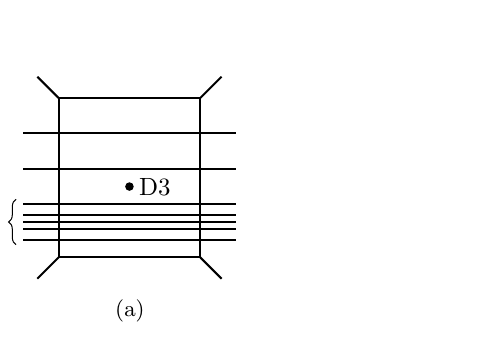
Figure 3 . Left: SU( N ) brane web with a D3-brane in a face separated by k = 3 D5-branes from the asymptotic region in the upward direction and separated by N (cid:0) k D5-branes from the asymptotic region in the downward direction. Right: con(cid:12)guration with k = 3 fundamental strings result- ing from Hanany-Witten transitions moving the D3-brane out in the upward direction. Avoided intersections are shown as broken